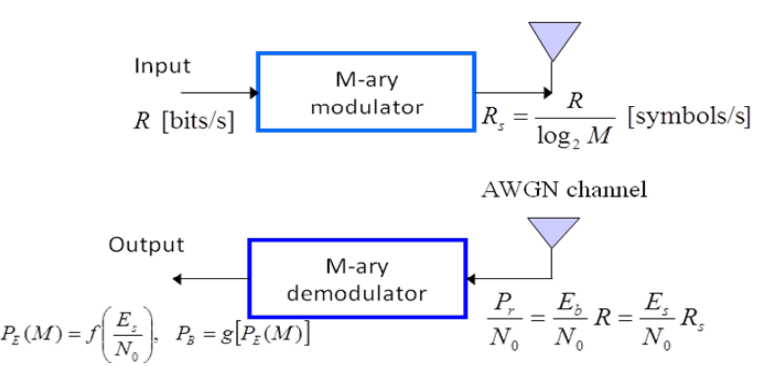
Figure 1. Basic modulator/demodulator without channel coding (Sklar,